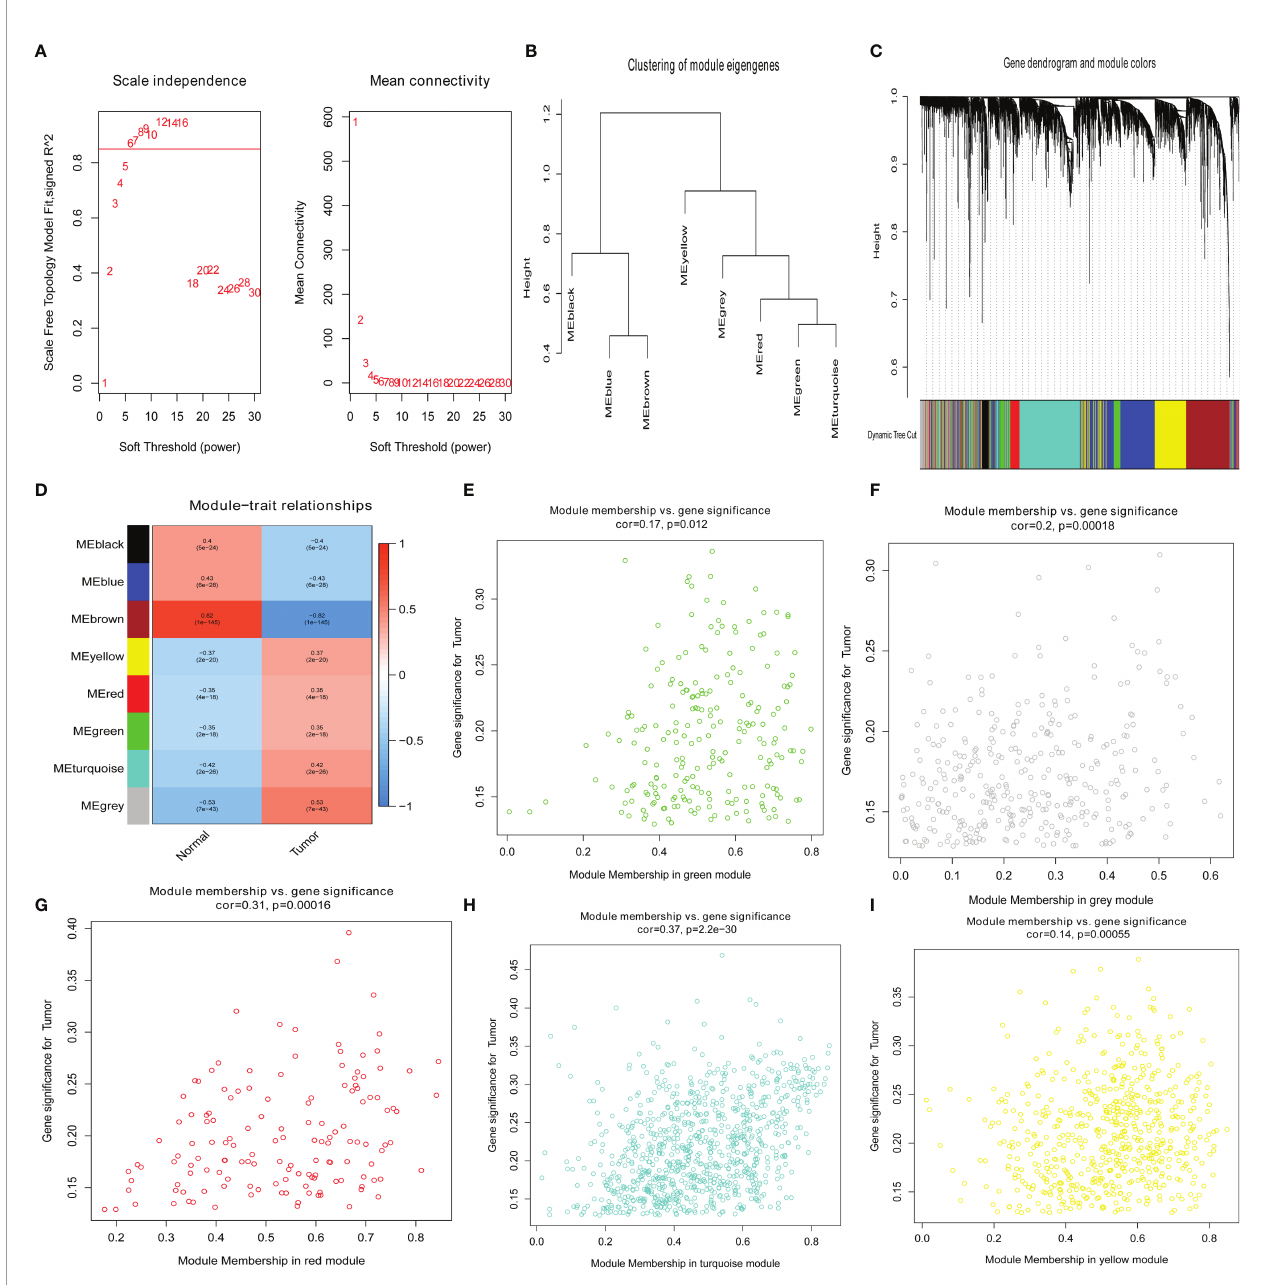
FIGURE 2 | Identi fi cation of key genes via the weighted correlation network analysis (WGCNA). (A) Analysis of the scale-free fi t index (left) and the mean connectivity (right) for various soft-thresholding powers. (B) Clustering dendrograms of genes based on a dissimilarity measure (1-TOM). (C) Module – trait associations were evaluated by correlations between module eigengenes and sample traits. (D – I) Scatterplot of gene signi fi cance for uterine corpus endometrial carcinoma (UCEC) in green, gray, red, turquoise, and yellow